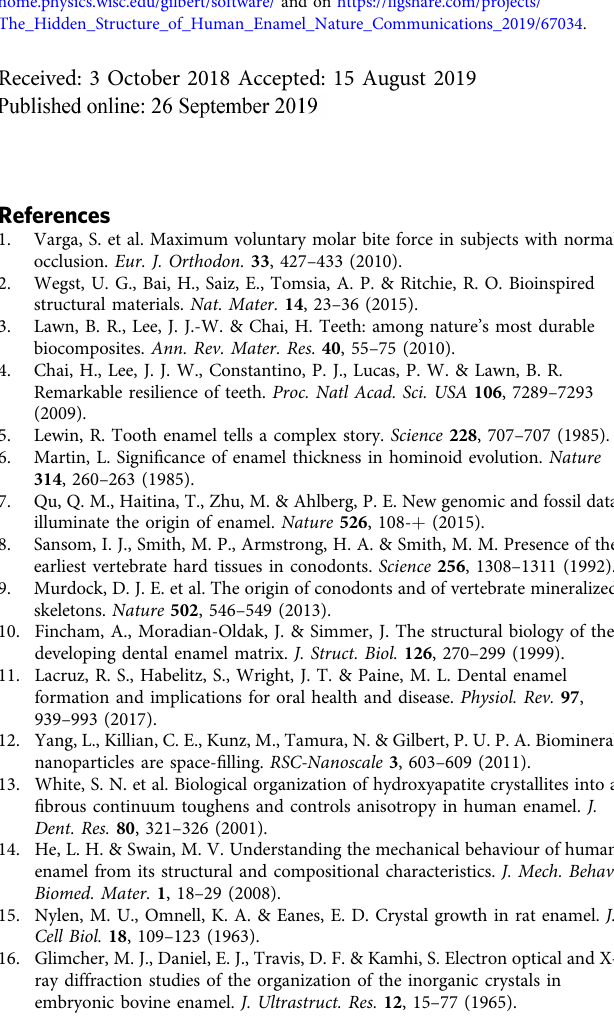
Fig. 1: H247 and H250. Acquired in September 2017. Fig. 2: Source data are provided as Source Data fi les H276, H279, H283, H284, H286, H288. Acquired in September 2017. Fig. 7: Source data are provided as Source Data fi les H108, H111, H113, H116, H118, H119. Acquired in September 2017. Supplementary Figure 12: Source data are provided as Source Data fi les H03, H04, H07, H08, H10, H11, H12, H13, H14, H15, H153, H154, H155, H156, H157, H158. Acquired in Jan. 2018. The bottom 6 panels are from Source Data fi les H335,